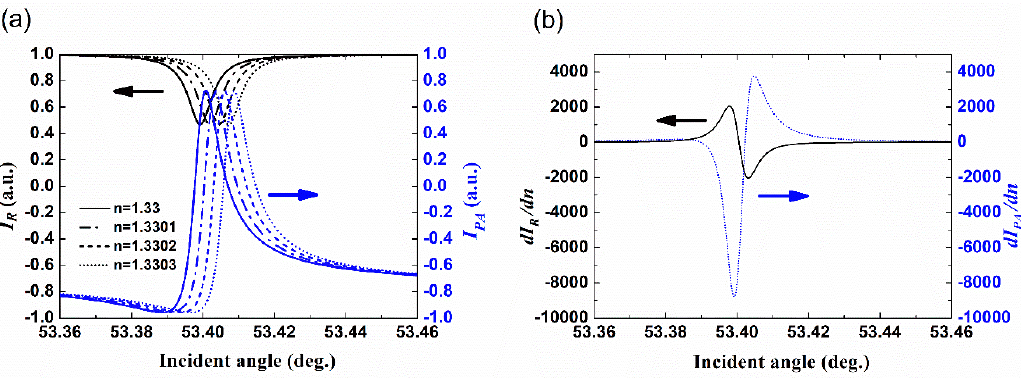
Figure 4. ( a ) The polarimetric-phase-enhanced intensity and the reflectance for different refractive indices with the BSW excitation. Solid lines: n = 1.33; ( b ) The sensitivities of the polarimetric-phase- enhanced intensity and the reflectance.